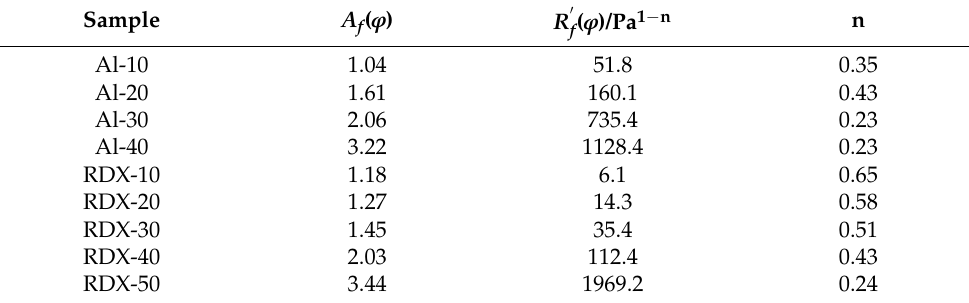
Figure 11. Relationship between G (cid:48) ( ω , ϕ ) / G (cid:48) m ( ω ) − G (cid:48) m ( ω ) (filled dot) and G (cid:48)(cid:48) ( ω , ϕ ) / G (cid:48)(cid:48) m ( ω ) − pG (cid:48)(cid:48) m ( ω ) (hollow dot) of solid-filled model propellant at 130 ◦ C. Table 5. Parameters of the two-phase model of model propellants. Sample